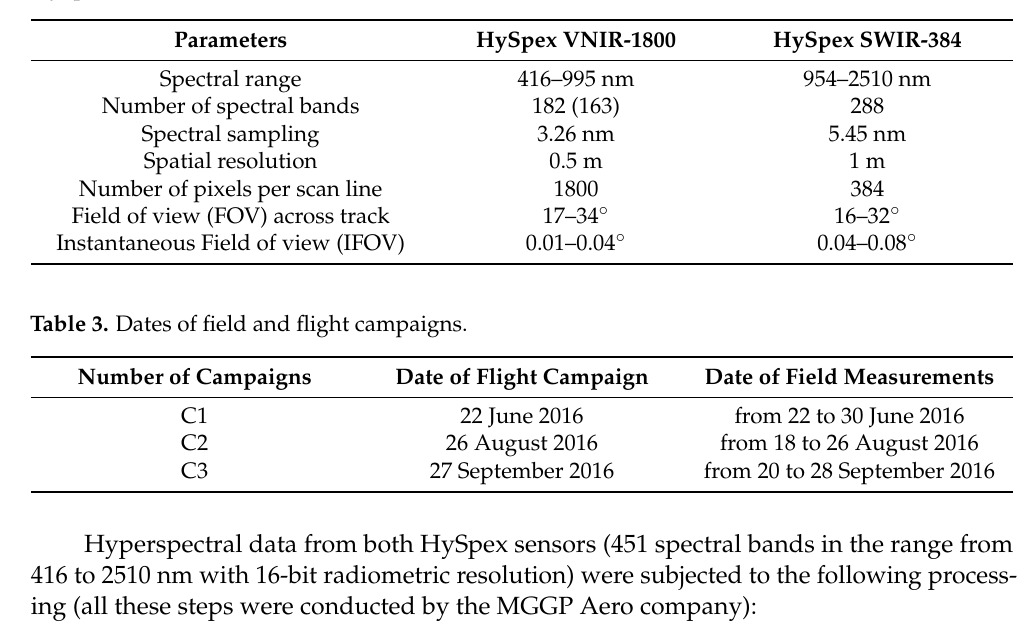
Table 2. Main technical characteristics of HySpex scanners used in this work. Due to overlapping of spectral ranges between VNIR-1800 and SWIR-384 sensors, we used 163 bands acquired by the HySpex VNIR-1800 scanners [32].